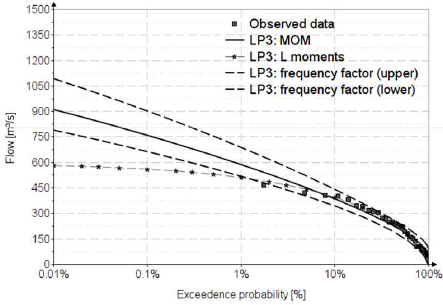
Figure 4. LogPearson III distribution.